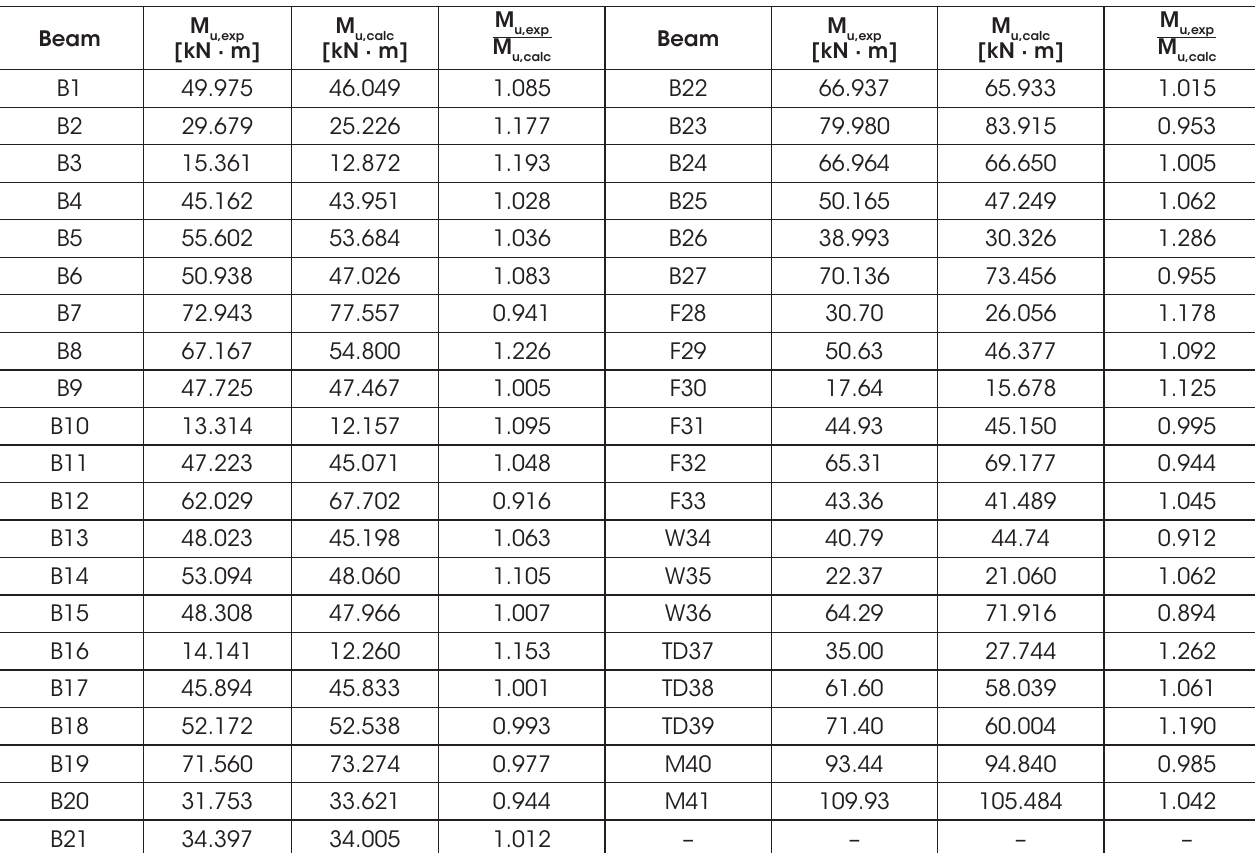
Experimental results versus numerical results